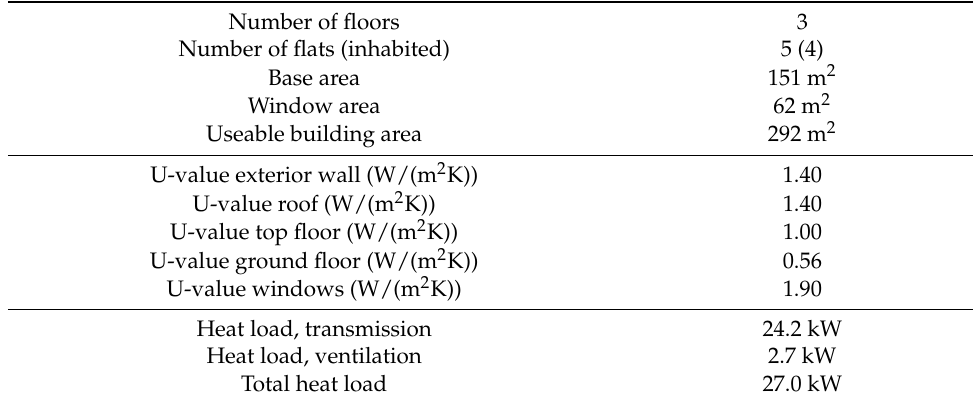
Table 1. Building data of the field trial.